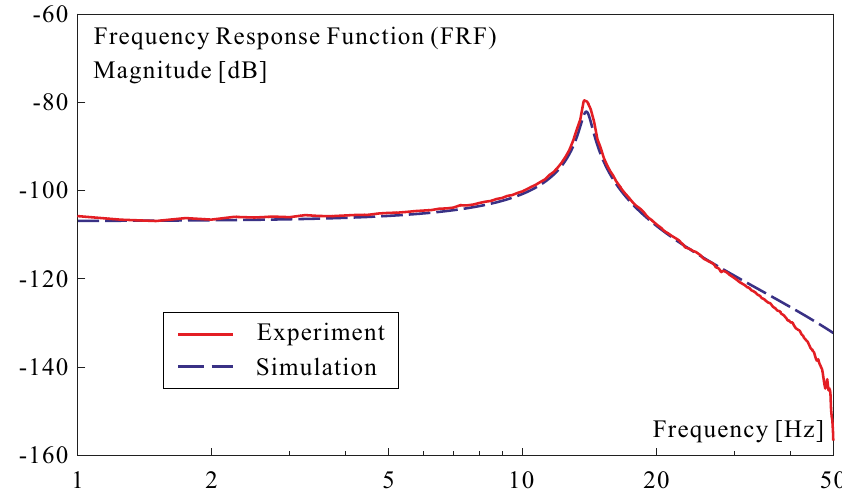
Figure 5. Typical FRF between the voltage applied to the electrodes and the displacement sensed by the optical scanning head; for this particular example, d 31 = 17 pC/N.